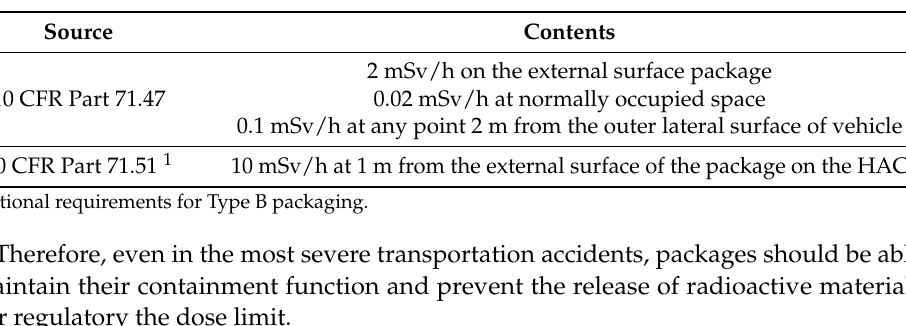
Table 7. Regulated radiation dose limits for transportation of radioactive